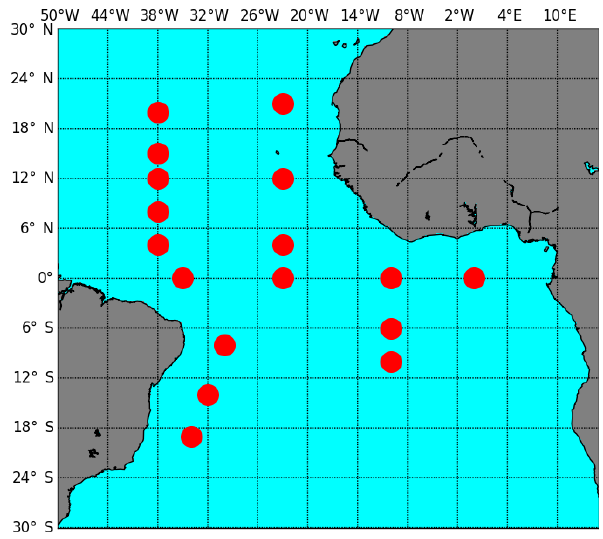
Figure 1. Map showing the location of the PIRATA